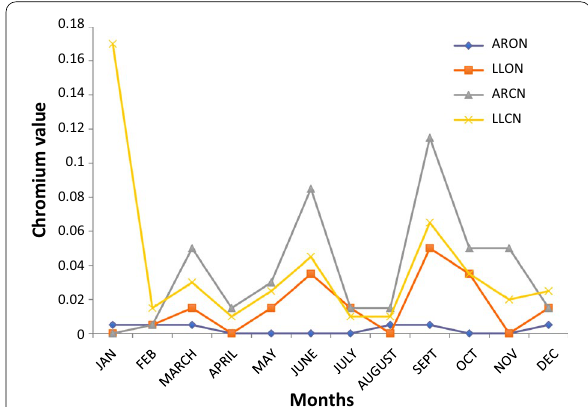
Fig. 3 Mean Comparative Chromium (Cr) concentration among C. nigrodigitatus and O. niloticus species collected from Asejire Reservoir and Lagos Lagoon